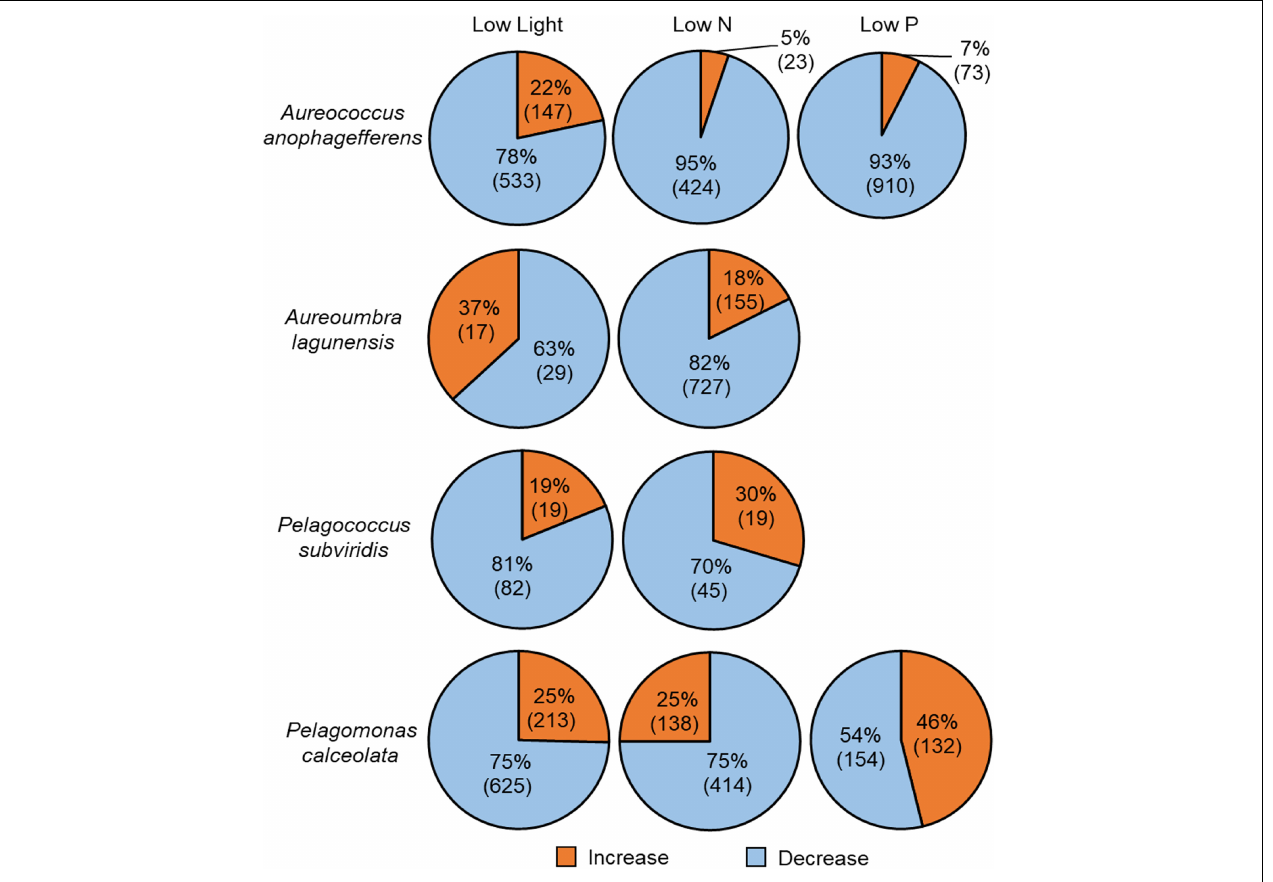
FIGURE 4 | Proportion of all differentially abundant OGs relative to control in each species across treatments and number in parenthesis indicates the number of differentially abundant OGs. Blue denotes significant decreases in relative abundance and orange denotes significant increases in relative abundance. No differentially abundant OGs were detected in the low P treatment for Aureoumbra lagunensis or Pelagococcus subviridis